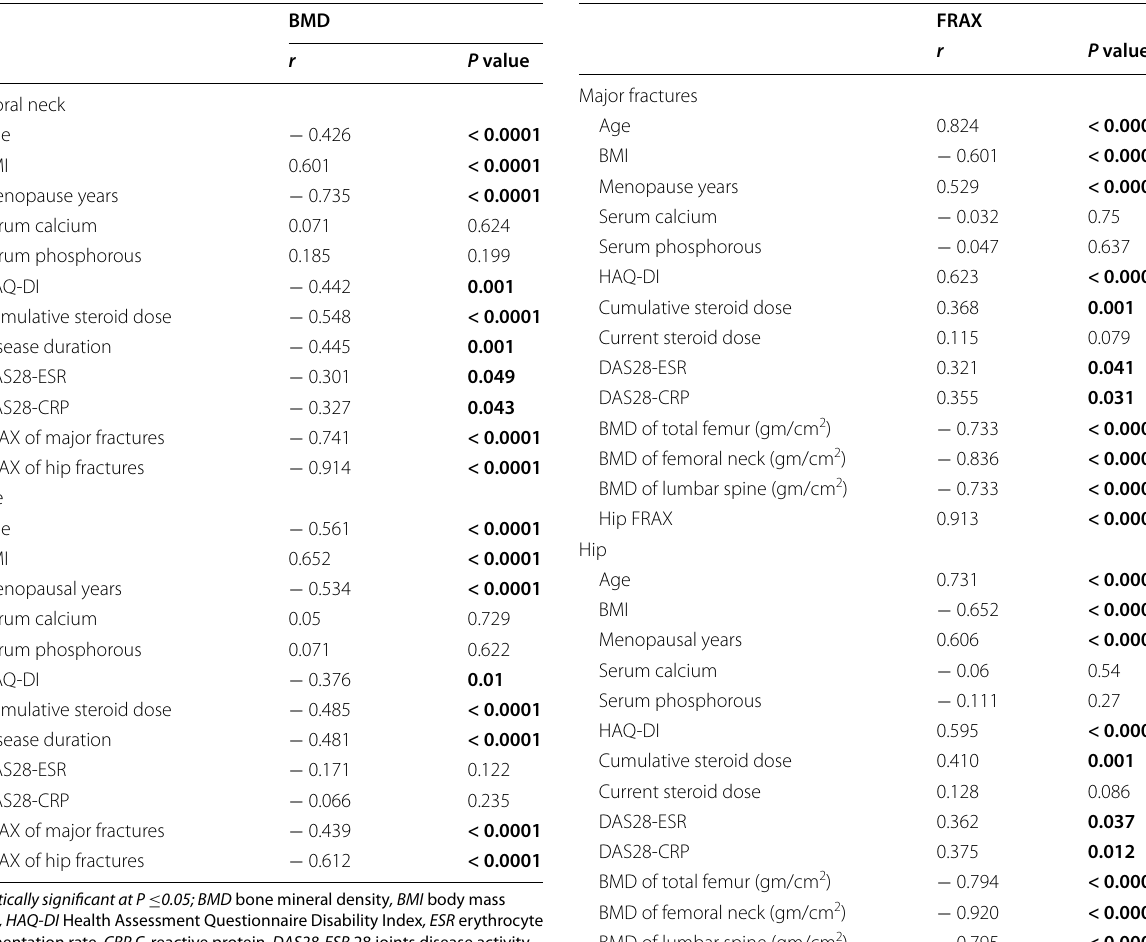
Table 2 Spearman’s correlation of BMD of the femoral head and lumbar spin with other variables in the RA group